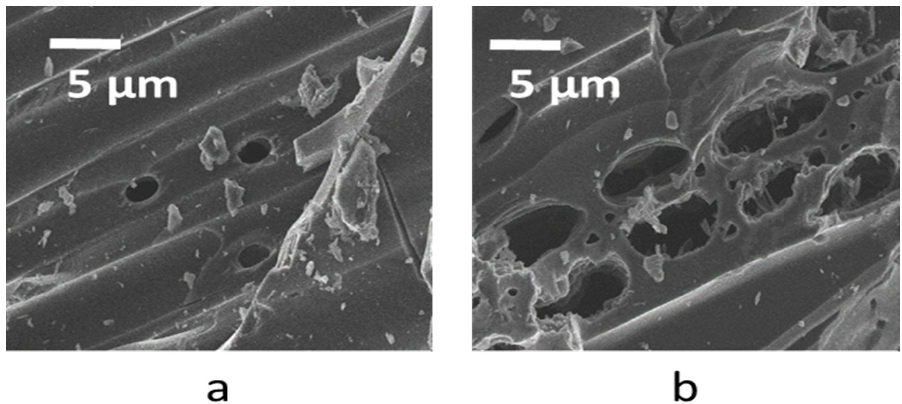
Figure 1. FESEM (Field Emission Scanning Microscopy) images of ( a ) biochar (BC) and ( b ) heat-treated biochar (BCHT).